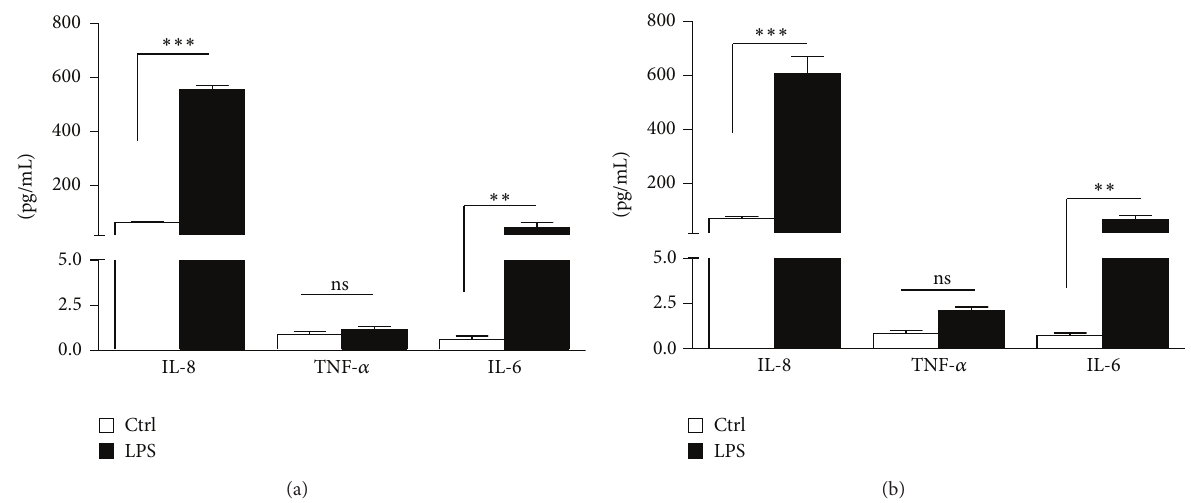
Figure 6: IL-8, TNF- 𝛼 , and IL-6 protein levels in supernatants from HaCaT cells stimulated or not with LPS (25 𝜇 g/mL) at (a) 24 and (b) 48 h ( ∗ 𝑃 < 0.05 , ∗∗ 𝑃 < 0.01 , and ∗∗∗ 𝑃 < 0.001 ; ns: not statistically